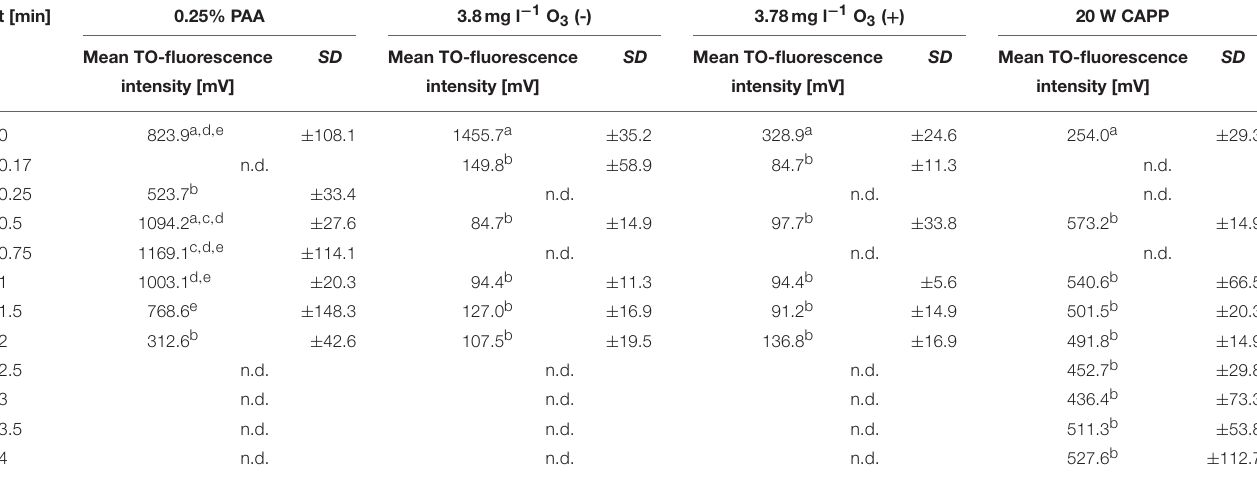
TABLE 1 | Mean TO-fluorescence intensity of E. coli after different treatments. t [min] Mean TO-fluorescence SD Mean TO-fluorescence SD Mean TO-fluorescence SD Mean TO-fluorescence intensity